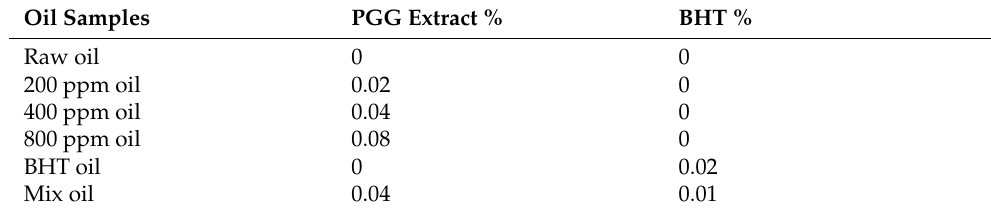
Table 1. Soybean oil samples’